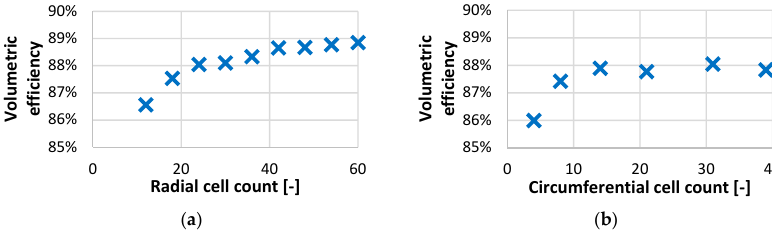
Figure 8. Influence of ( a ) N r at N c = 31 and ( b ) N c at N r = 42 on the volumetric e ffi